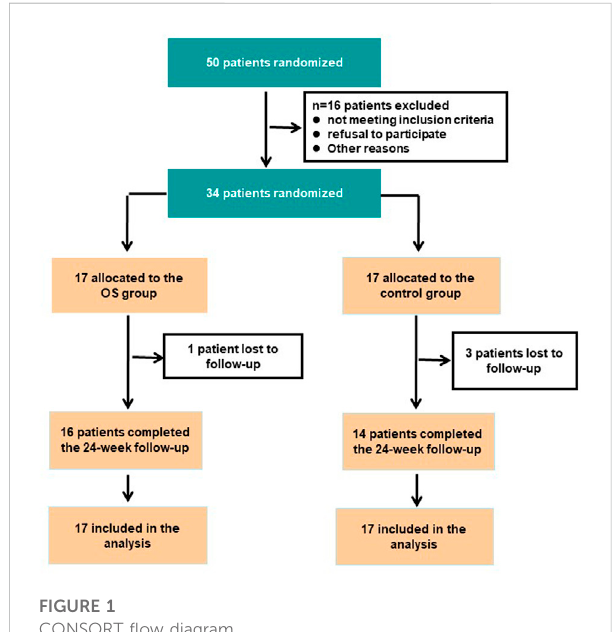
FIGURE 1 CONSORT fl ow